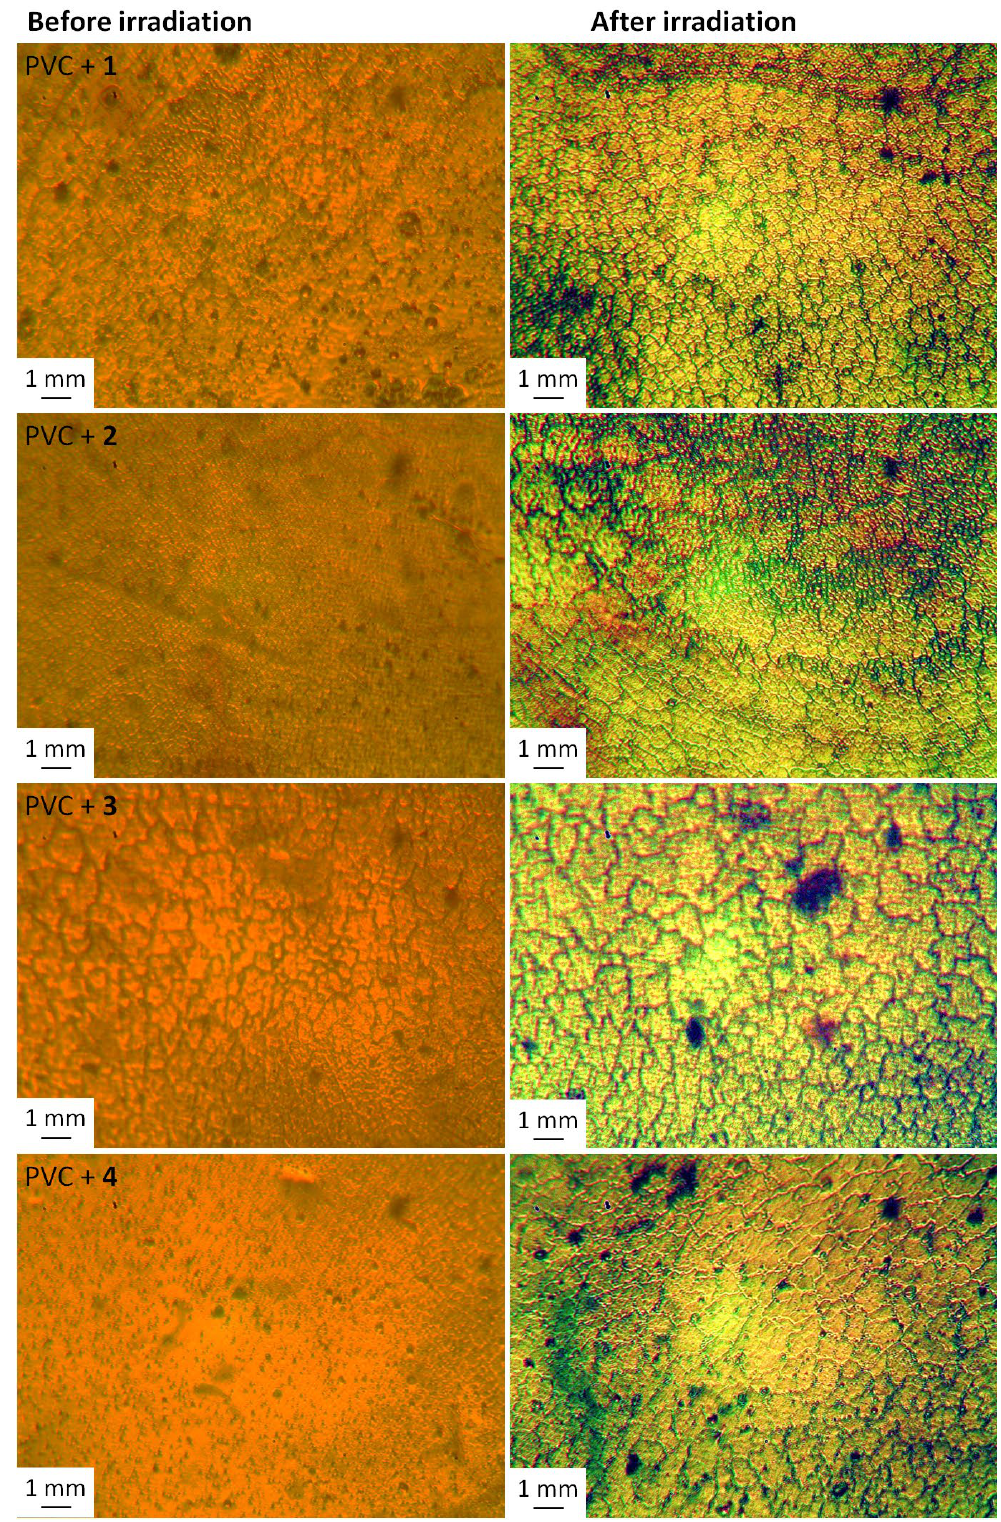
Figure 7. Optical microscopic images of PVC films before and after irradiation.